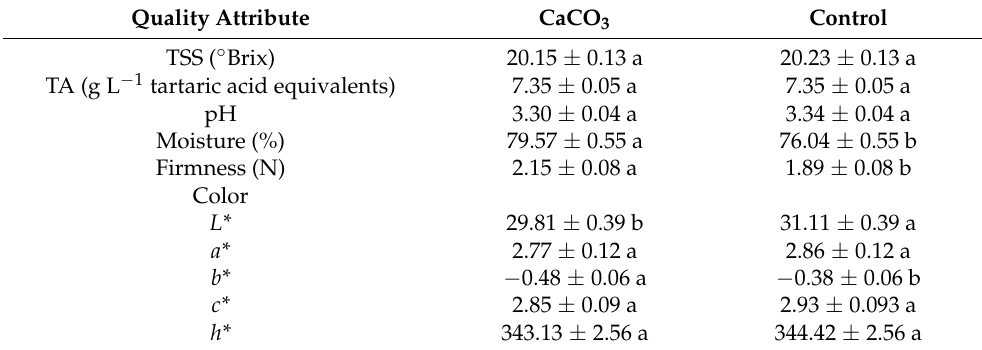
Table 3. Effect of the foliar application of CaCO 3 on the general characteristics of ‘Shiraz’